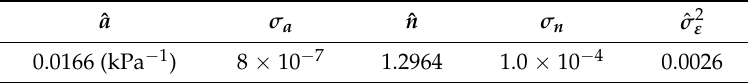
Table 1. Summary of statistics of posterior Table1. Summary of statistics of posterior distributions.